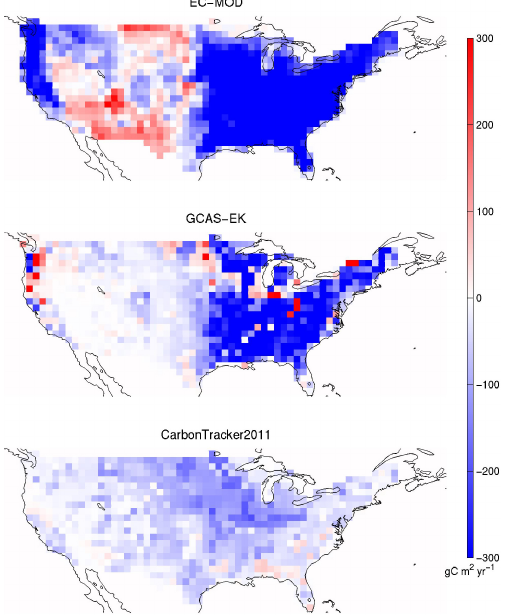
Figure 11. The distribution of averaged net ecosystem exchange (gCm − 2 yr − 1 ) from 2002 to 2006 for conterminous U.S. by EC- MOD, GCAS-EK and CarbonTracker 2011, respectively. The pat- tern correlation coefficient is 0.47 between EC-MOD and GCAS- EK, and 0.22 between CarbonTracker 2011 and